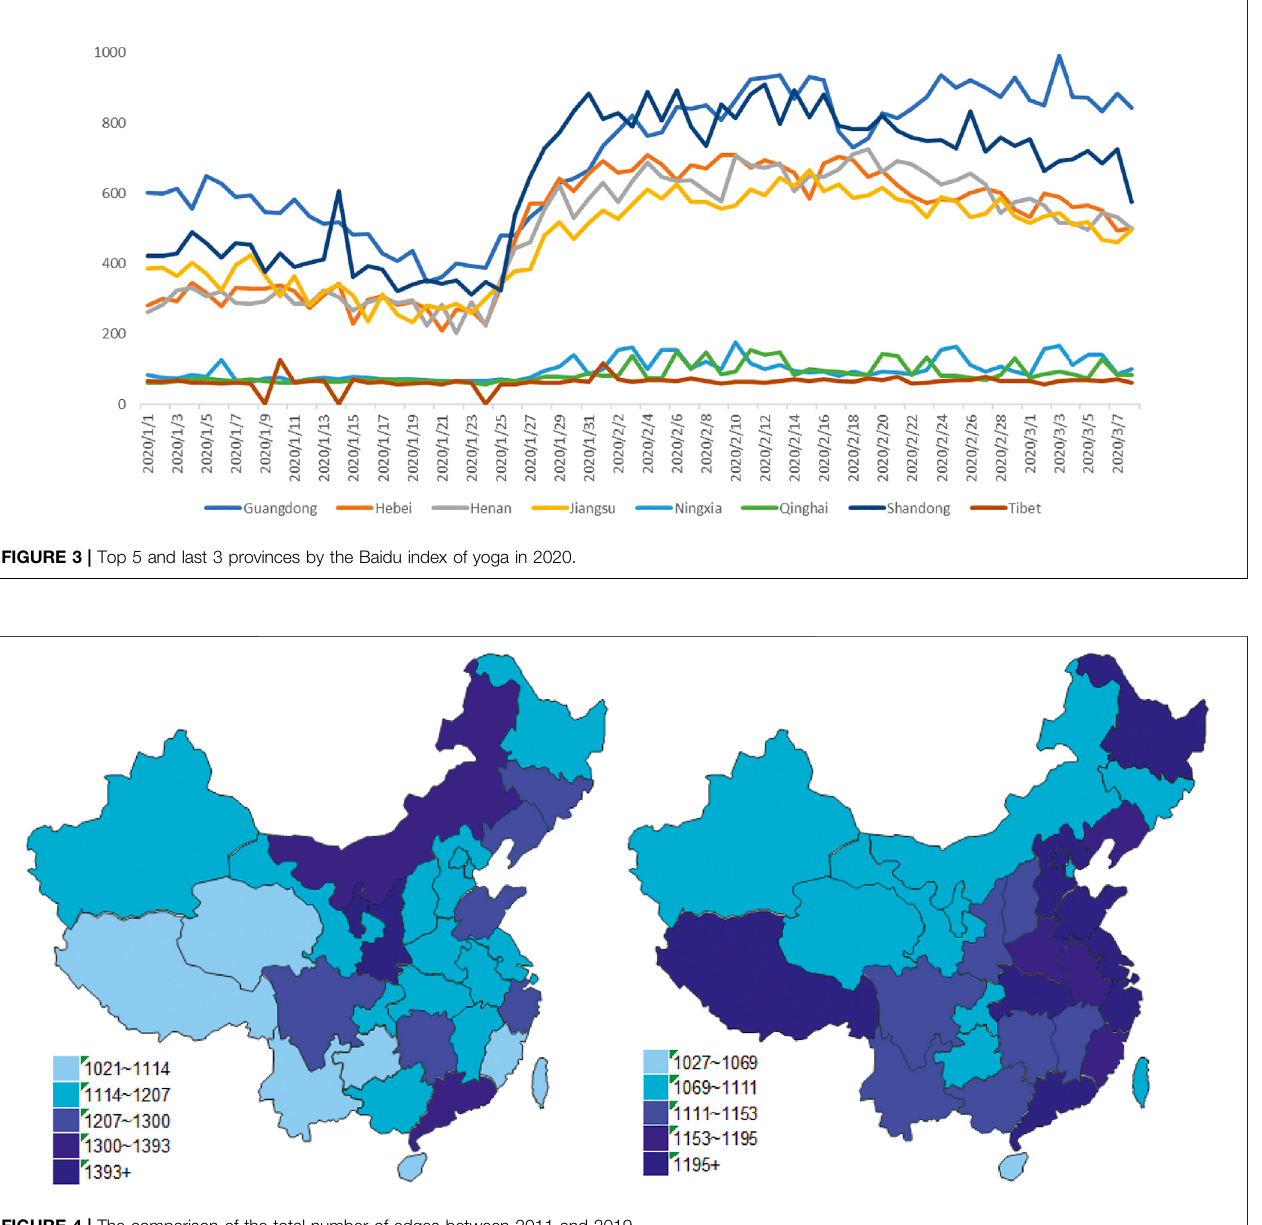
FIGURE 4 | The comparison of the total number of edges between 2011 and